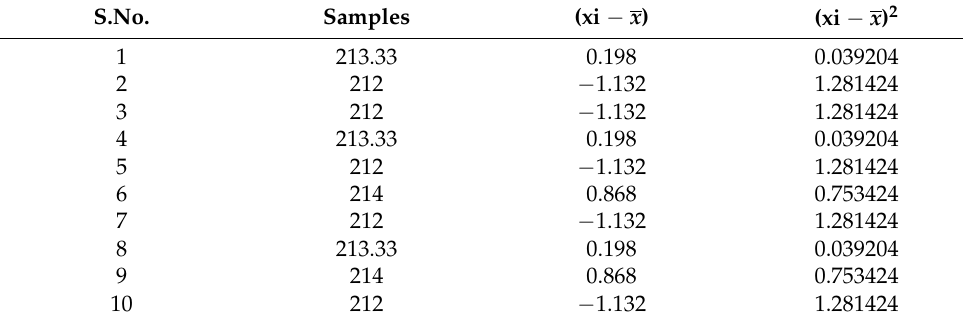
Table 5. t -test on the samples collected in June